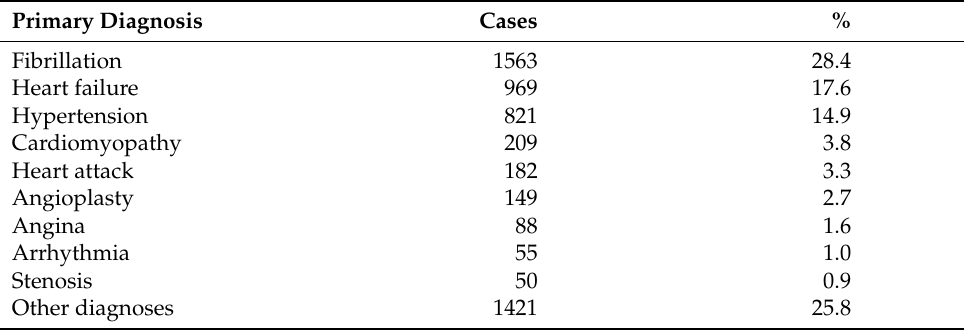
Table 1. Primary diagnosis associated with heart disease in the chronic patients.